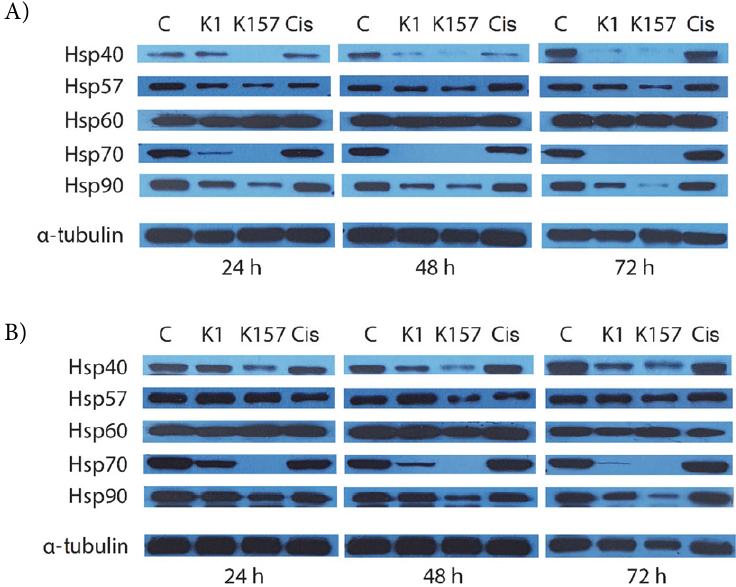
Figure 3. Effects of IC50 concentrations of homobrassinin (K1), thiazino[6,5-b]indol (K157), and cisplatin (Cis) on HSP40, HSP57 (PDI), HSP60, HSP70, and HSP90 in A2780 (A) and A2780cis (B) cell lines. The cells were grown in standard growth media for 24 h and then treated with